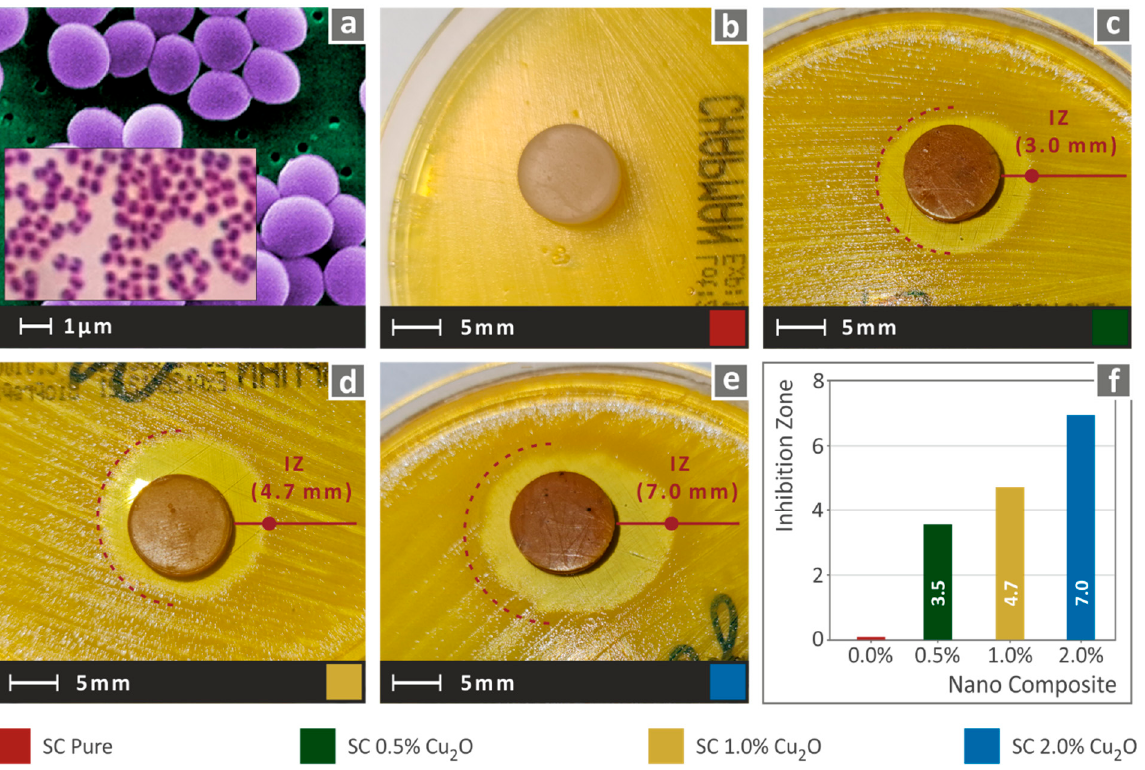
Figure 9. ( a ) typical S. aureus morphology, ( b – e ) Vertical captures after 24 h cultivation of tested specimen in a petri dish for each corresponding tested material, ( f ) Comparative graph of the measured inhibition zones to filler loading (wt.%).